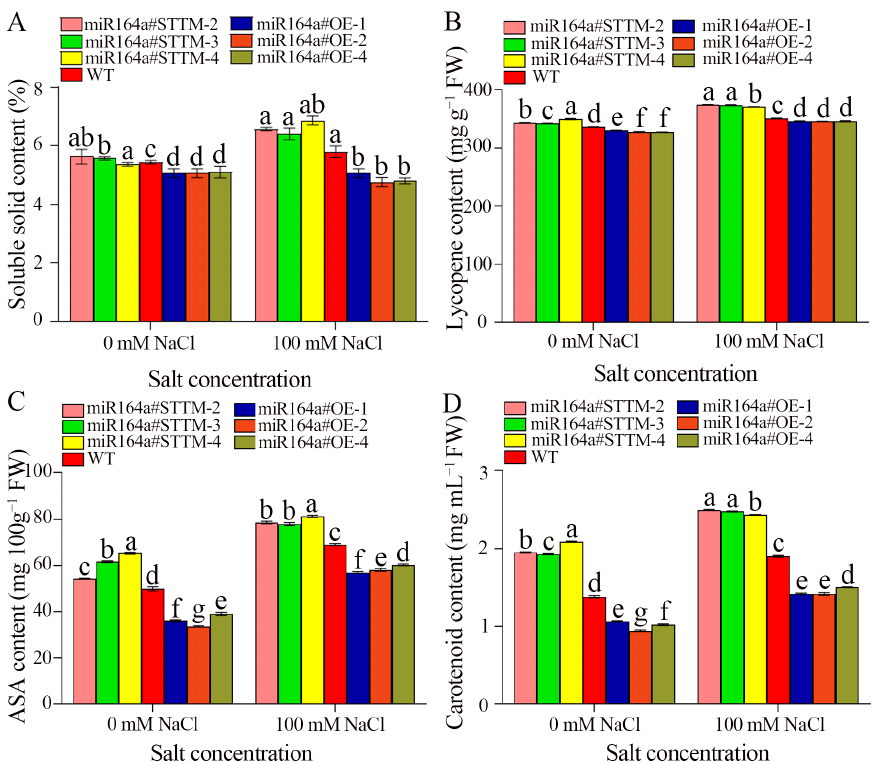
Figure 6. The contents of soluble solids ( A ), lycopene ( B ), ASA ( C ), carotenoids ( D ) in miR164a#STTM, WT and miR164a#OE postharvest tomato fruit during salt treatment. Vertical bars represent standard deviations of the means, n = 3. Different letters indicated significant differences between WT and transgenic tomatoes in the values at p < 0.05.